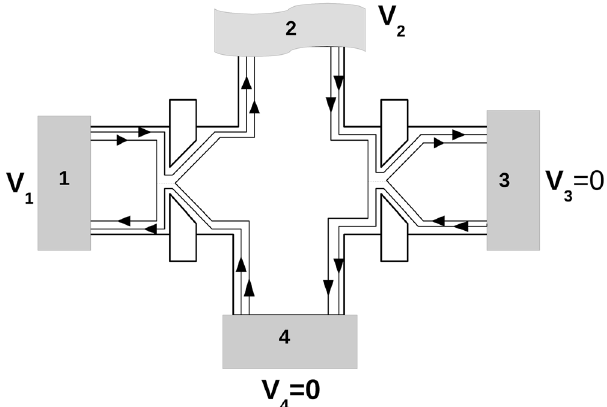
Figure 4. The Texier, et al .,/Oberholzer, et al ., set-up as in refs 32 and 33 to detect positive non-local HBT correlations in a quantum Hall set up. Here, probe 2 is a voltage probe ( = I 0 ) while probes 3 and 4 are 2 detectors kept at zero voltage. Note that by using constrictions inside the sample and having edge modes transmitting with different probabilities one can engineer positive non-local correlations. However, in the set- ups we have in this work positive non-local correlation in quantum Hall regime are